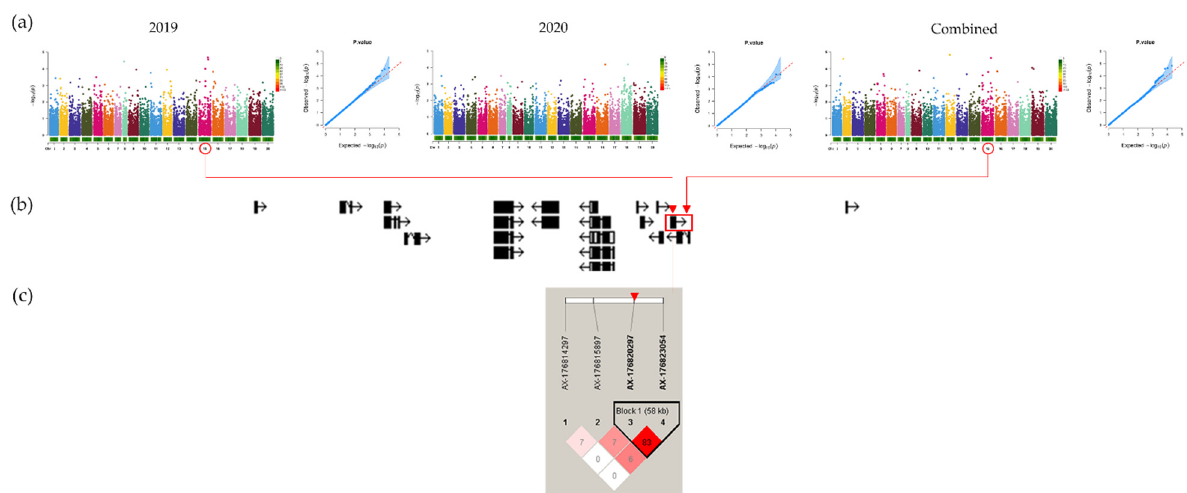
Figure 3. ( a ) A Manhattan plot of a genome-wide association analysis using GAPIT and a Q-Q (quantile–quantile) plot; ( b ) Genes located at the association regions based on the Arachis hypogaea Tifrunner 1.0 reference genome; the Arahy.SDG4EV gene is marked in a red square pattern showing that it was found in both the 2019 and the combined season GWAS results; ( c ) A linkage disequilibrium (LD) plot generated using HaploView software showing r 2 values for selected AX-176820297 SNP on chromosome Araip.B05 within diamonds. Significant combined p values are highlighted in red.